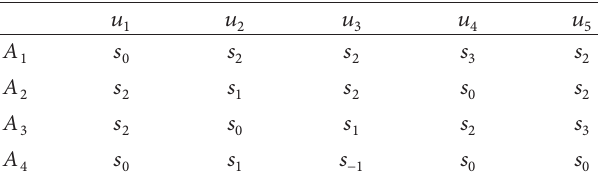
Table 2: The evaluation values of four alternative hubs given by expert 𝑑 2 .